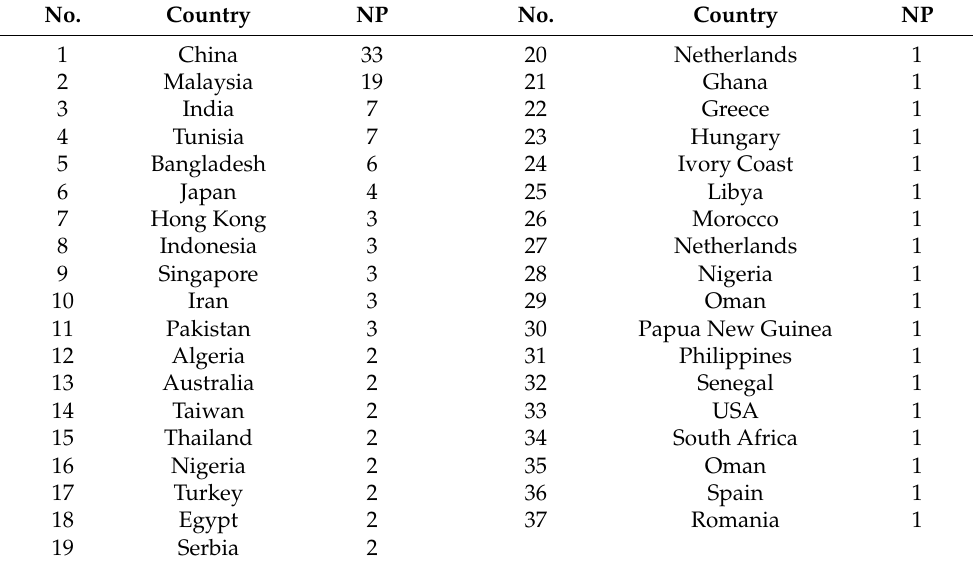
Table 2. Overall number of papers (NP) reported in different countries out of the 125 papers cited in the present study. No. Country NP No. Country NP 1